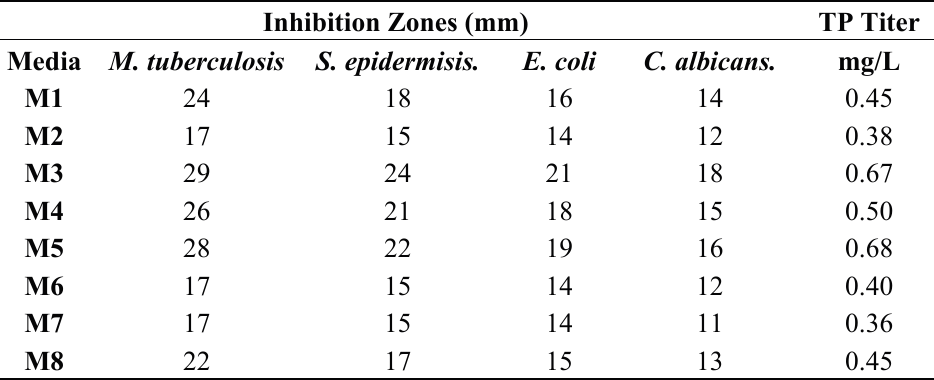
Table 5. TP titer and antimicrobial activity of S. mutabilis supernatant using different fermentation media.